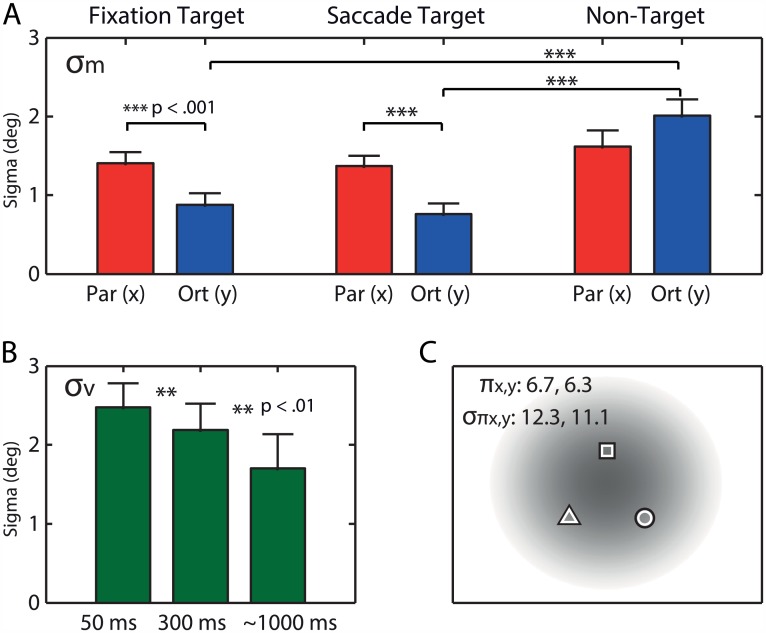
Mean parameters of best-fits.(A) Average σm across participants (error bars, SEM). The orthogonal component of the memorized positions appears to be more precise than the parallel component for FT and ST, but not for NT. (B) Average σvacross participants. Variability of the postsaccadic-target representation decreases as a function of viewing duration. (C) Prior π, positioned relative to FT, representing where objects are generally expected to appear. All values are in degrees.